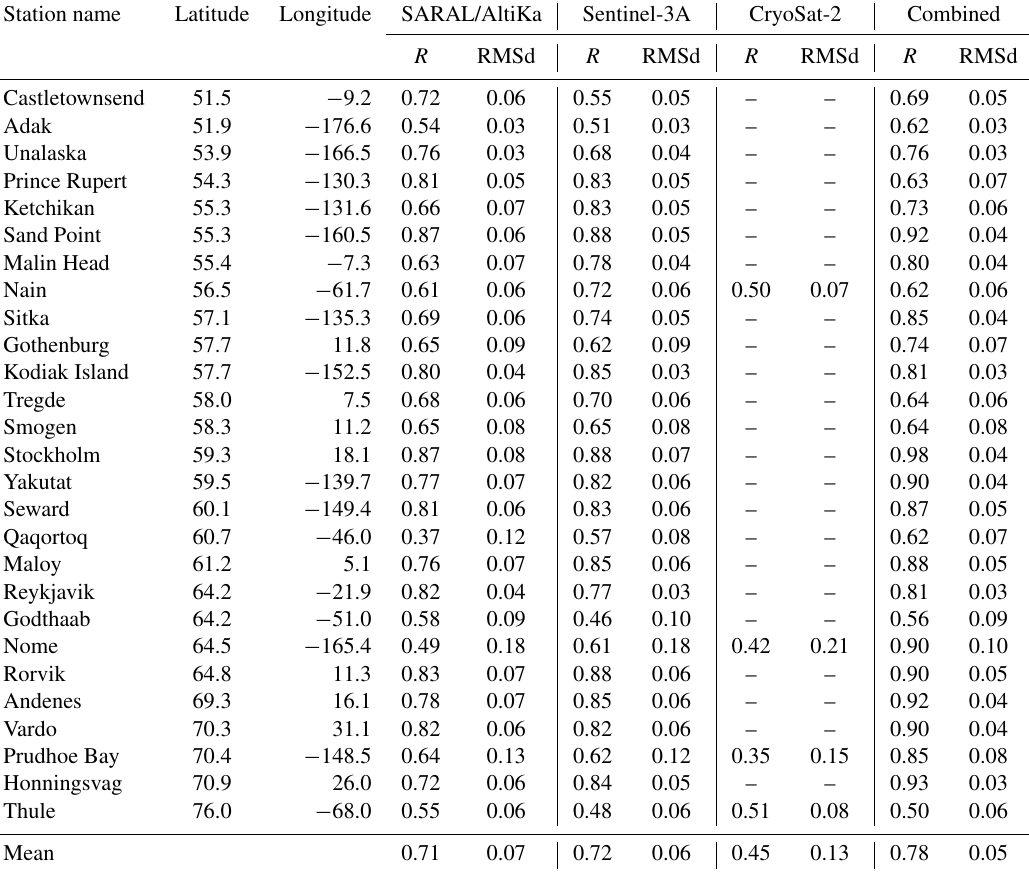
Table 5. Comparisons to tide gauges. RMSd values are given in